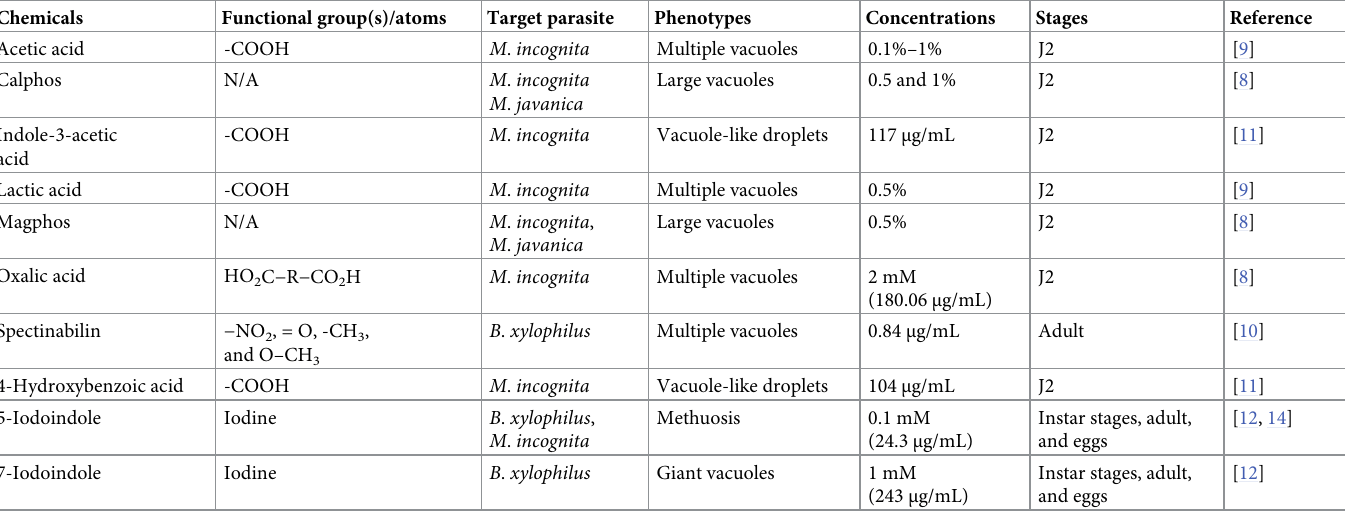
Table 1. Chemicals that trigger vacuole formation in parasitic